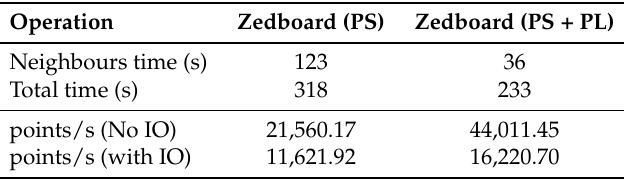
Table 6. Hardware acceleration for the Vaihingen data.